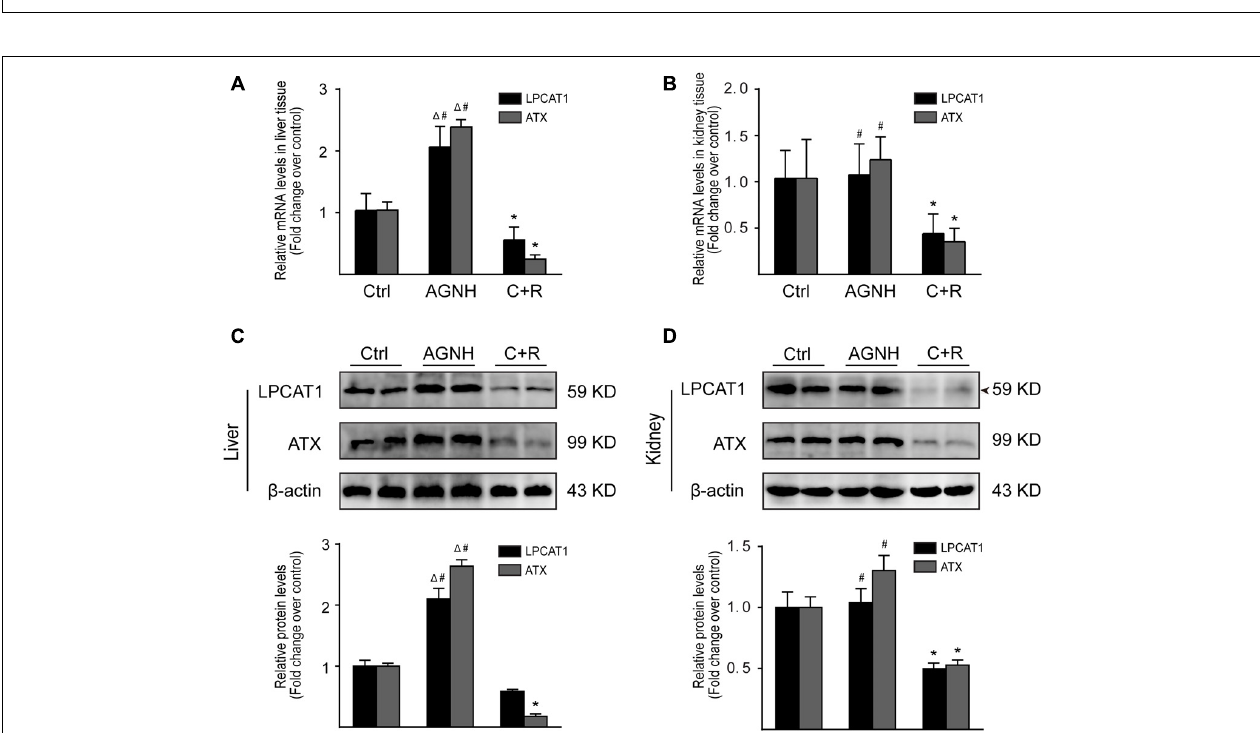
FIGURE 9 | RT-qPCR analysis of gene expression was performed for LPCAT1 and ATX in the liver (A) and kidneys (B) from saline control (Ctrl), An-Gong-Niu-Huang Wan (AGNH) and cinnabar and reaglar co-administration (C+R) groups. The mRNA level of each target gene was normalized to the expression of the β -actin gene. Representative Western blotting photographs illustrating protein levels of LPCAT1, ATX and β -actin in the (C) liver and (D) kidney tissue lysates. β -Actin was used as an internal control. For quantitation of the protein levels of LPCAT1 and ATX, band intensities were converted to arbitrary densitometric units, normalized to the value of β -actin and expressed relative to the value of the same protein in vehicle-treated mice, which was defined as one-fold. Each bar represents mean ± SD for six mice. ∗ P < 0.05 saline control versus cinnabar and reaglar co-administration; # P < 0.05, An-Gong-Niu-Huang Wan versus cinnabar and reaglar co-administration; (cid:49) P < 0.05, saline control versus An-Gong-Niu-Huang Wan.